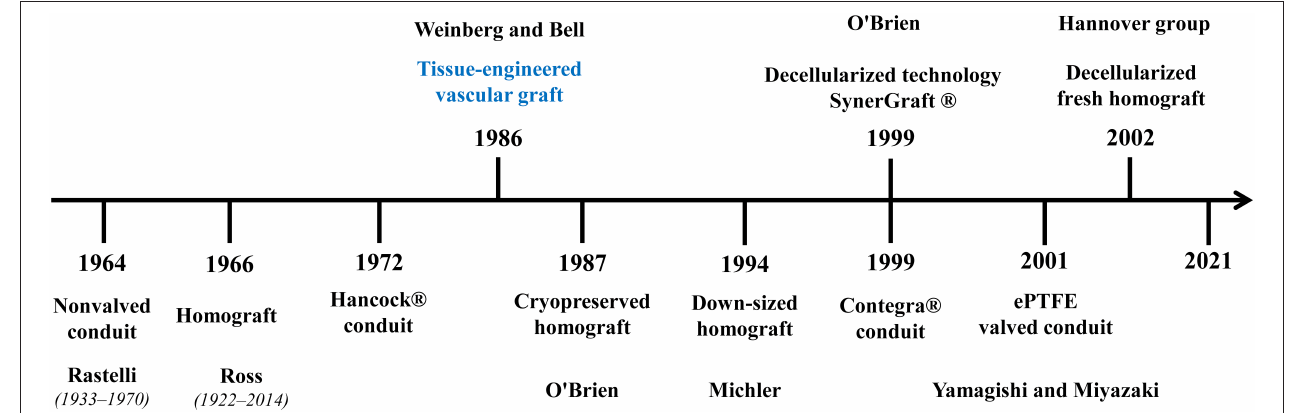
FIGURE 1 | Development of small-sized conduits for RVOT reconstruction. The commonly used conduit materials for RVOT reconstruction were listed in the figure in chronological order with the founder(s) (if any). Tissue engineered vascular graft has the potential to achieve an ideal conduit, but it is still in